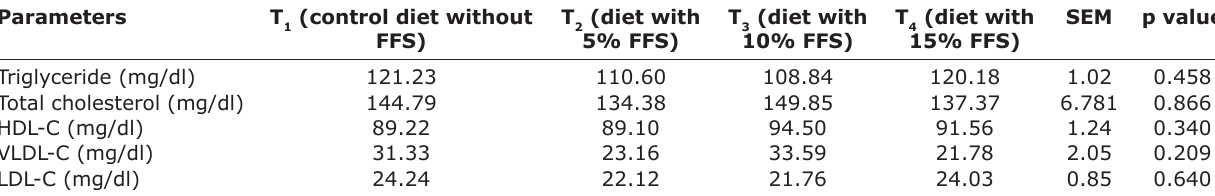
Table-5: Effect of dietary supplementation of FFS on serum lipid profile (mg/dl) of broiler Japanese quails at 5 weeks of age. Parameters